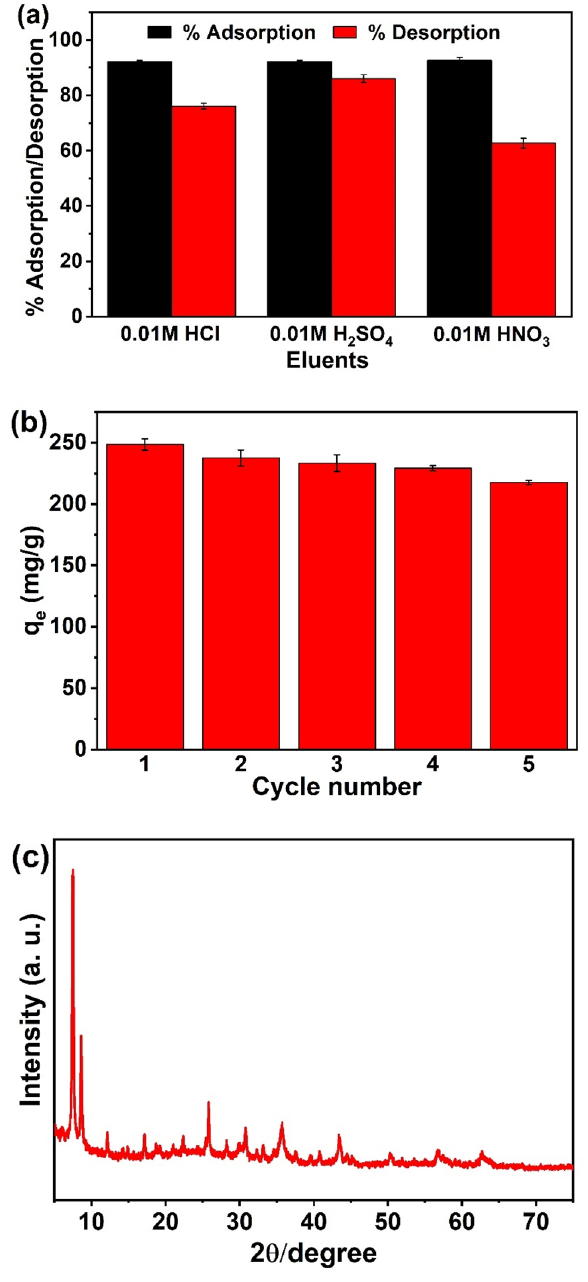
Figure 9. Desorption ( a ) and recyclability ( b ) studies of Fe 3 O 4 @SiO 2 @UiO 2 -66-TPP NPs. ( c ) XRD pattern of the utilized